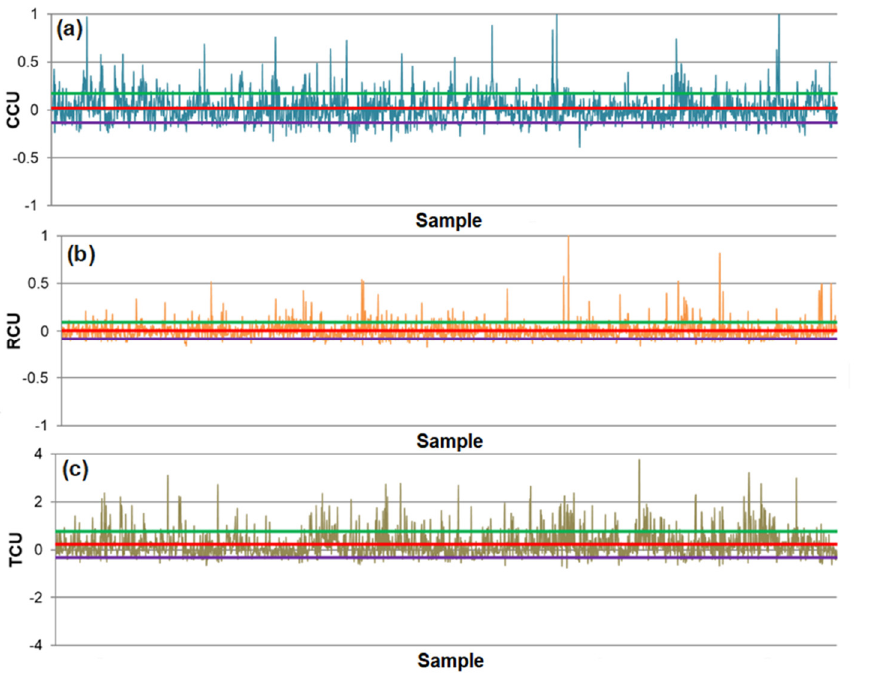
Figure 23. Relative prediction errors of technological indicators according to the ( a ) NN1, ( b ) NN2 and ( c ) NN3 models. The red line on the charts represents mean (μ r ), green line value μ r + 1 SDE r and violet line value μ r − 1 SDE r .